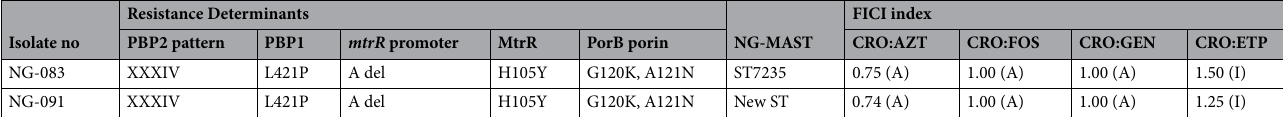
Table 5. Summary of antibiotic combinations against N. gonorrhoeae clinical isolates NG-083 and NG-091 with reduced susceptibility to ceftriaxone (n = 2), Thailand, 2016–2018. AZT azithromycin, CRO